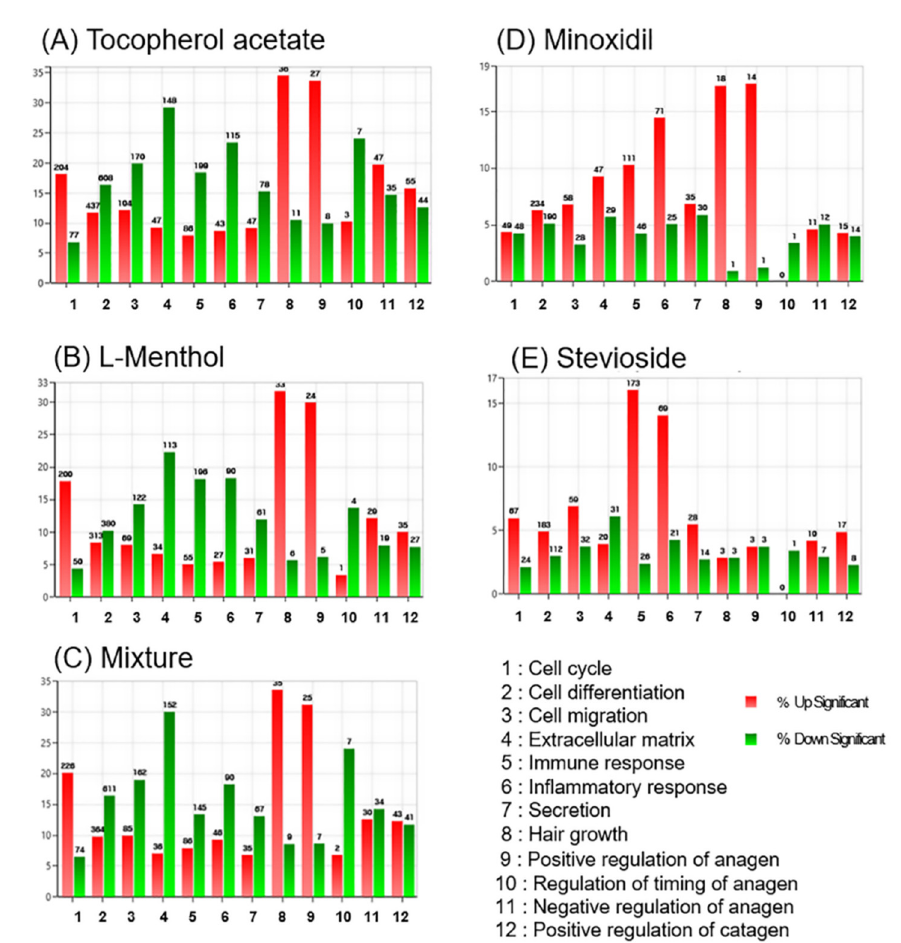
Figure 5. Gene category chart of ( A ) tocopherol acetate vs. CTR, ( B ) L-menthol vs. CTR, ( C ), L-menthol + tocopherol acetate + stevioside vs. CTR, ( D ) minoxidil vs. CTR and ( E ) stevioside vs. CTR. CTR =